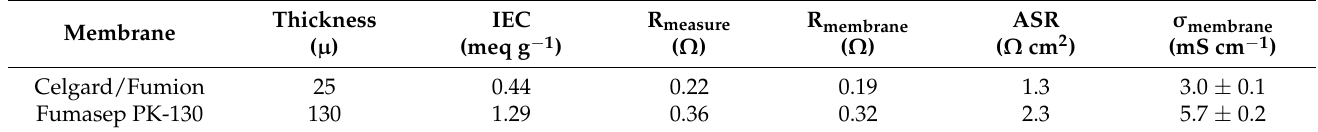
Table 2. IEC and conductivity of sample membranes.